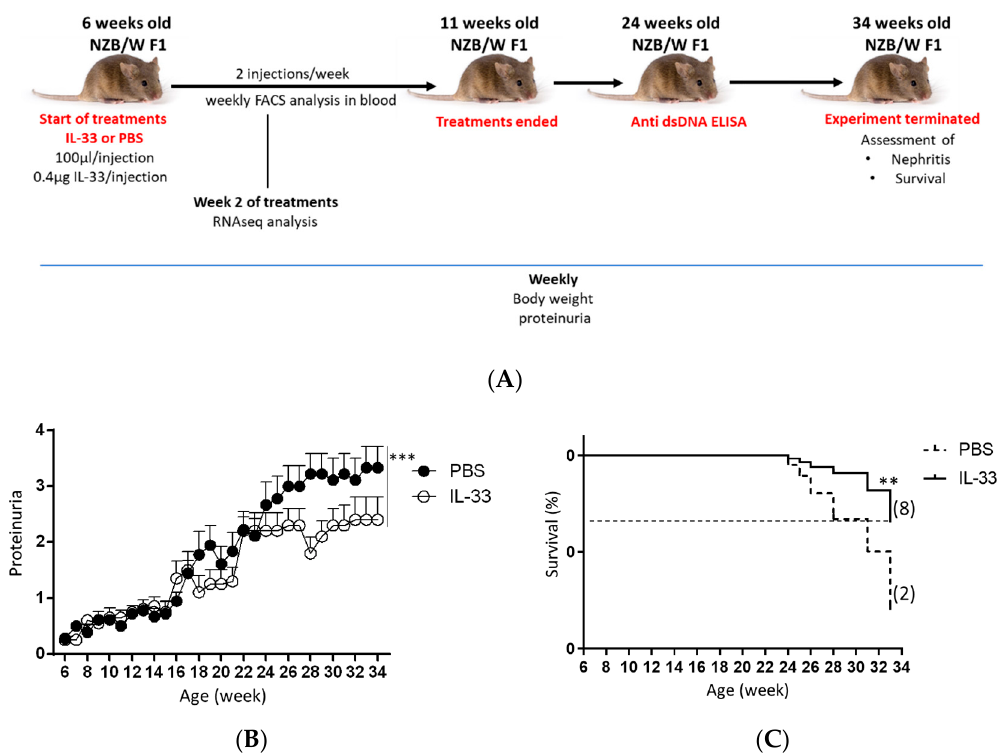
Figure 1. Suppressed proteinuria level and mortality rate in NZB/W F1 mice treated with interleukin-33 (IL-33). Beginning at 6 weeks of age, NZB/W F1 mice were given peritoneal treatments of IL-33 or PBS, two times a week for five continuous weeks. ( A ) Experimental outline. ( B ) Proteinuria was measured bi-weekly and graded as 0+, 1+, 2+, 3+, or 4+. Values represent the mean ± SEM. *** p < 0.001, analyzed by two-way ANOVA. ( C ) Survival rate (percentage) showing mice that had to be sacrificed due to severe lupus (more than 3+ proteinuria and 20% loss of body weight). Kaplan–Meier survival curves, n = 12, analyzed by log-rank test, ** p < 0.01. The numbers of mice surviving to 33 weeks of age are shown in parentheses. Results represent two independent experiments.